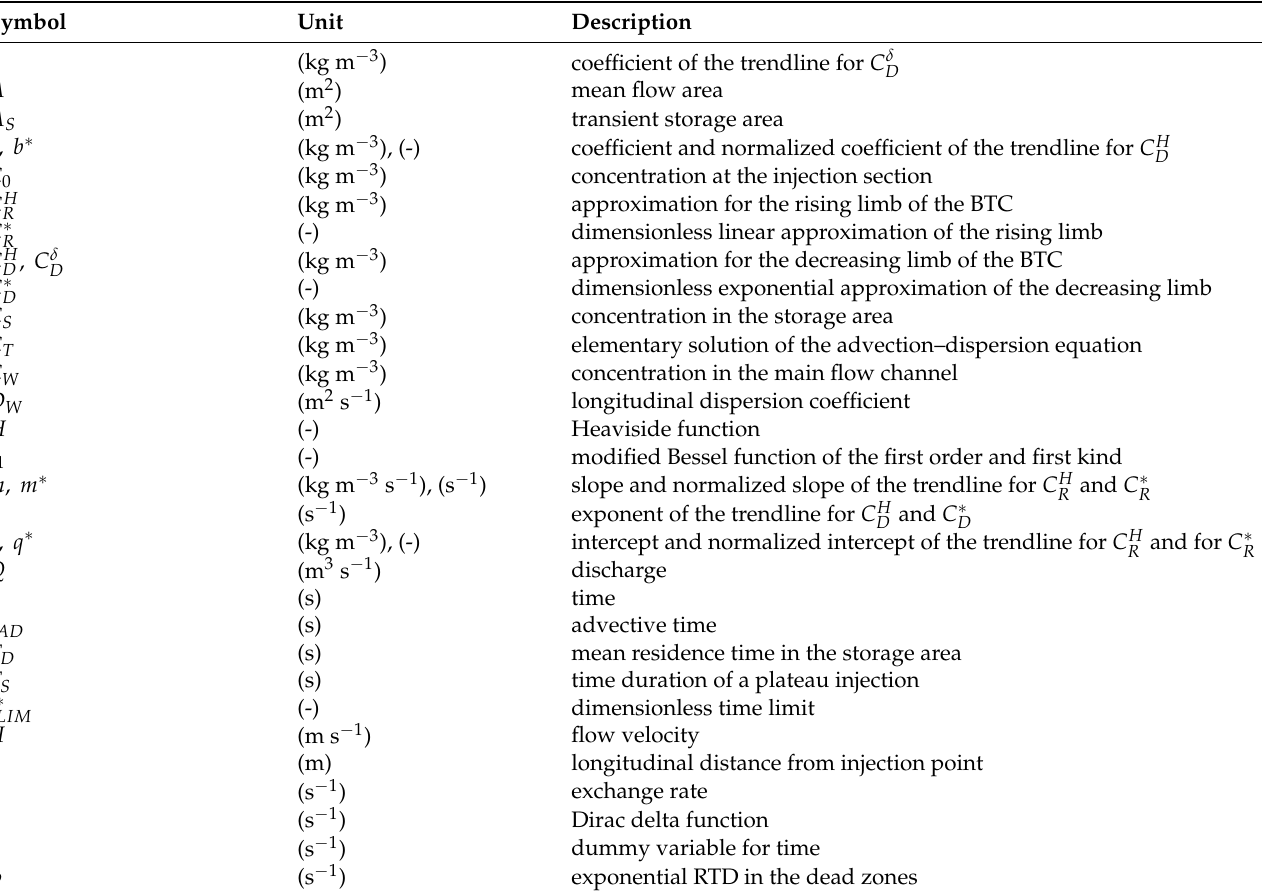
Table A1. Notation list of all the symbols used in the